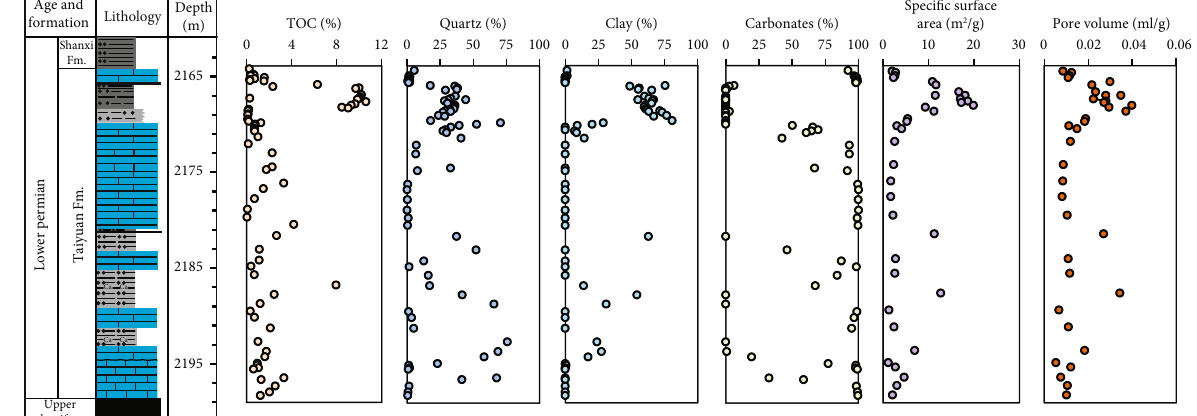
Figure 4: Vertical distribution of TOC content, mineral, and pore characteristics for Taiyuan shales and limestones.